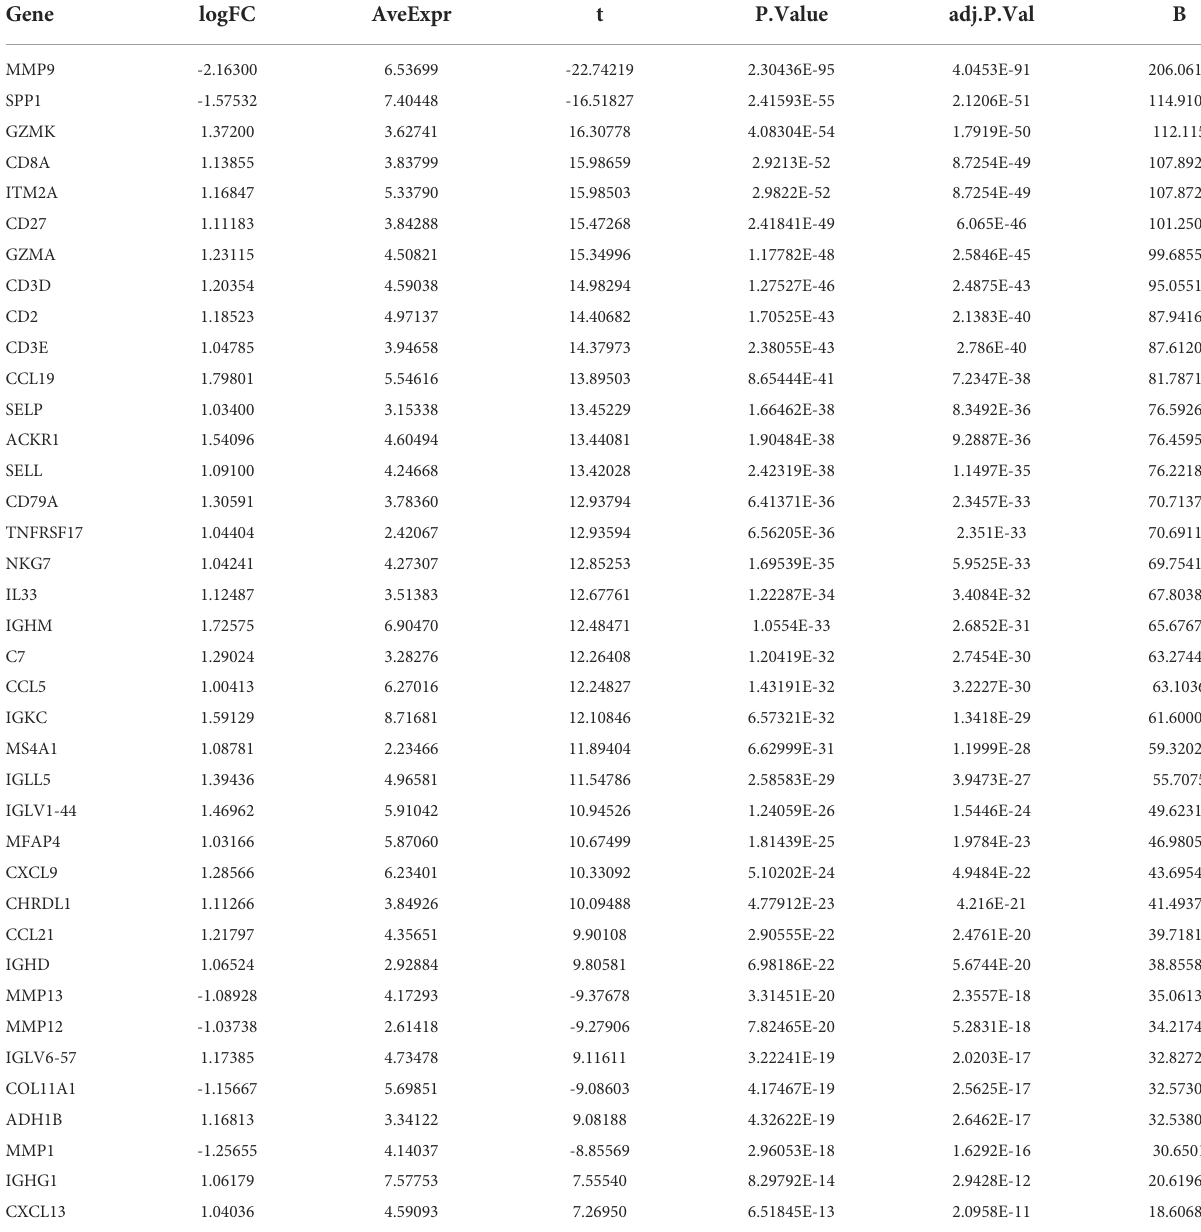
TABLE 1 Comparison of different obfuscations in terms of their transformation